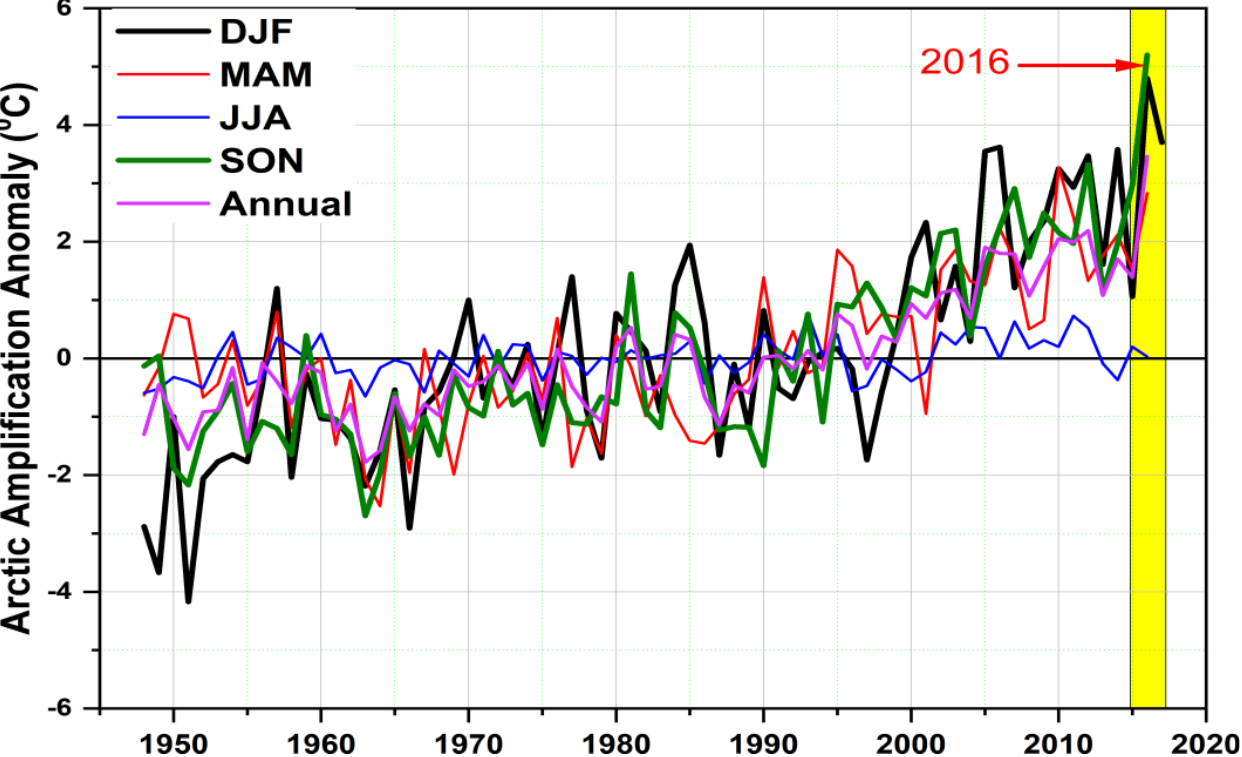
Figure 1. Arctic amplification seasonal time series based on the differences in the 925 mb temperature anomalies between the Arctic region (70° N – 90° N) and mid-latitudes (30° N – 60° N).